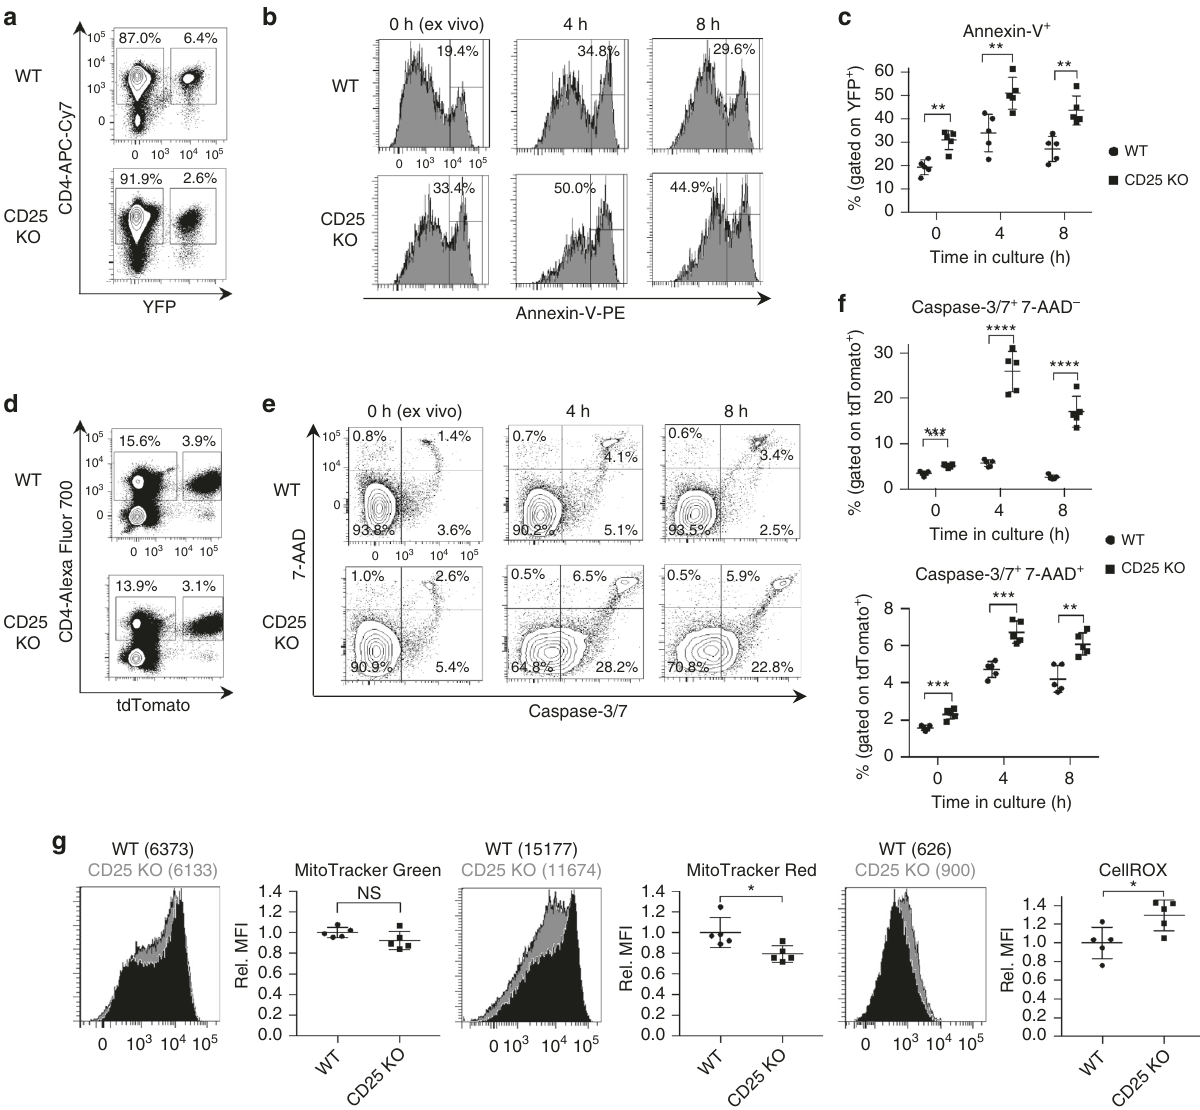
Fig. 9 Increased apoptosis and mitochondrial dysfunction in CD25-de fi cient peripheral Tregs. a Representative contour plots and gating strategy for YFP + Tregs among splenic CD4 + T cells bead-puri fi ed from CD25 fl ox/Foxp3eGFP-Cre-ERT2/R26Y mice (shown as CD25 KO) and reporter controls 10 – 14 days after tamoxifen induction. b Representative histograms and ( c ) scatter plot showing Annexin-V staining, performed ex vivo and after 4 h and 8 h incubation in culture media alone (n = 5 mice per group). Cells are gated on the YFP + population shown in ( a ). d Representative contour plots and gating strategy for tdTomato + Tregs among splenic CD4 + T cells from CD25 fl ox/Foxp3eGFP-Cre-ERT2/R26TD mice (shown as CD25 KO) and reporter controls evaluated 10 – 14 days after tamoxifen induction. e Representative contour plots and ( f ) scatter plots showing staining with caspase-3/7 enzyme substrate and 7-AAD ( n = 5 mice per group). Cells are gated on the tdTomato + population shown in ( d ). g Representative histograms and scatter plots of MFI data for tdTomato + cells stained with MitoTracker Green, MitoTracker Red, and CellROX oxidative stress detection reagent ( n = 5 mice per group). Rel. MFI = relative MFI normalized to CD25 WT controls. Each symbol represents an individual mouse (mean ± SD). NS, not signi fi cant ( p > 0.05), * p < 0.05, ** p <